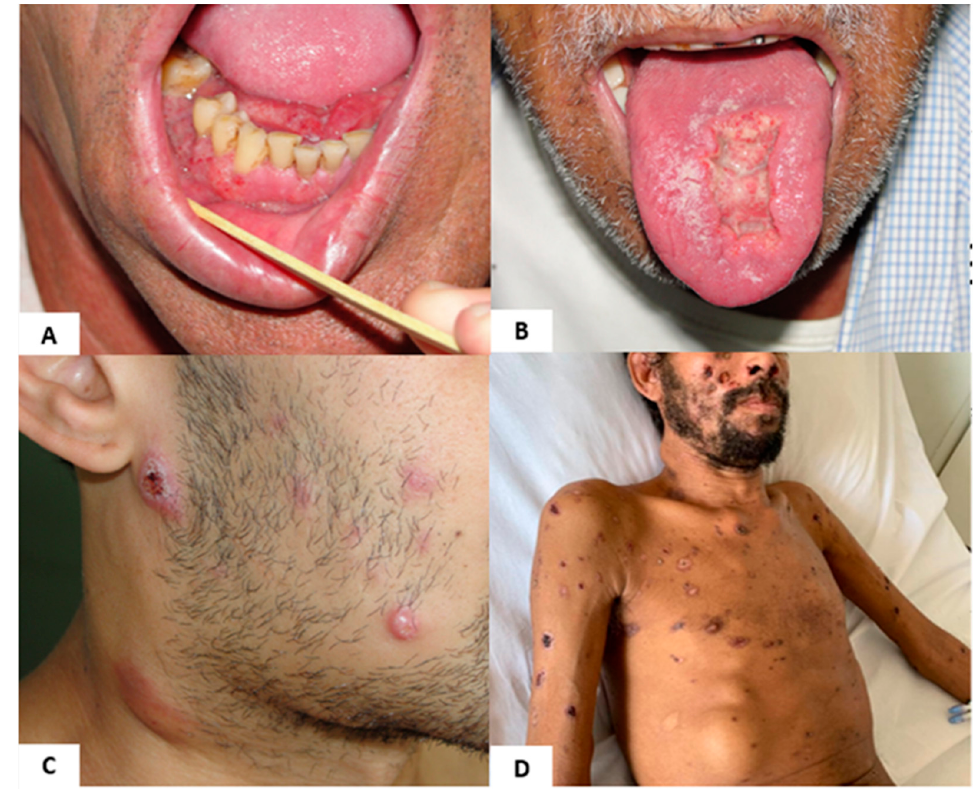
Figure 2. ( A ) Chronic form: gingival and lingual frenulus “mulberry-like” ulcers with hemorrhagic dots; ( B ) chronic form: deep ulcerative lesion on the tongue with infiltrative borders, hemorrhagic dots, covered with fibrin; ( C ) acute/subacute form: multiple polymorphic (nodular, papular, and ulcerated) skin lesions and cervical inflammatory lymphadenopathy; ( D ) disseminated form in a patient with PCM and HIV co-infection; the following may be seen: cervical lymphadenopathy, exuberant ulcerated, crusted skin lesions, and larges subcutaneous abscesses in the thorax and abdomen.